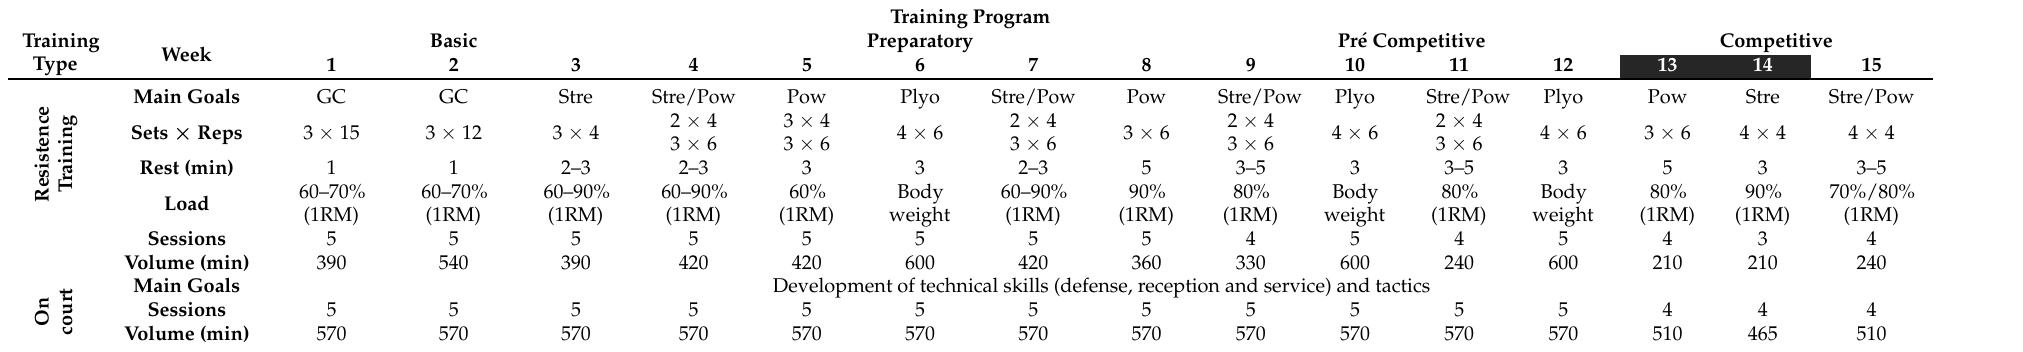
Table 1. The training schedule comprised the number of each training session at the gym and at the volleyball court (technical-tactical) and the training volume of the weekly training throughout the 15-week preparatory and competitive periods. The black square indicates weeks with official volleyball matches. GC = general conditioning. STRE = strength. POW = power; PLYO) =